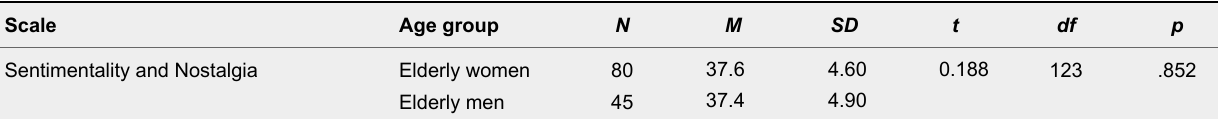
Differences in Sentimentality and Nostalgia Between Genders in Greece Scale Age group Sentimentality and Nostalgia